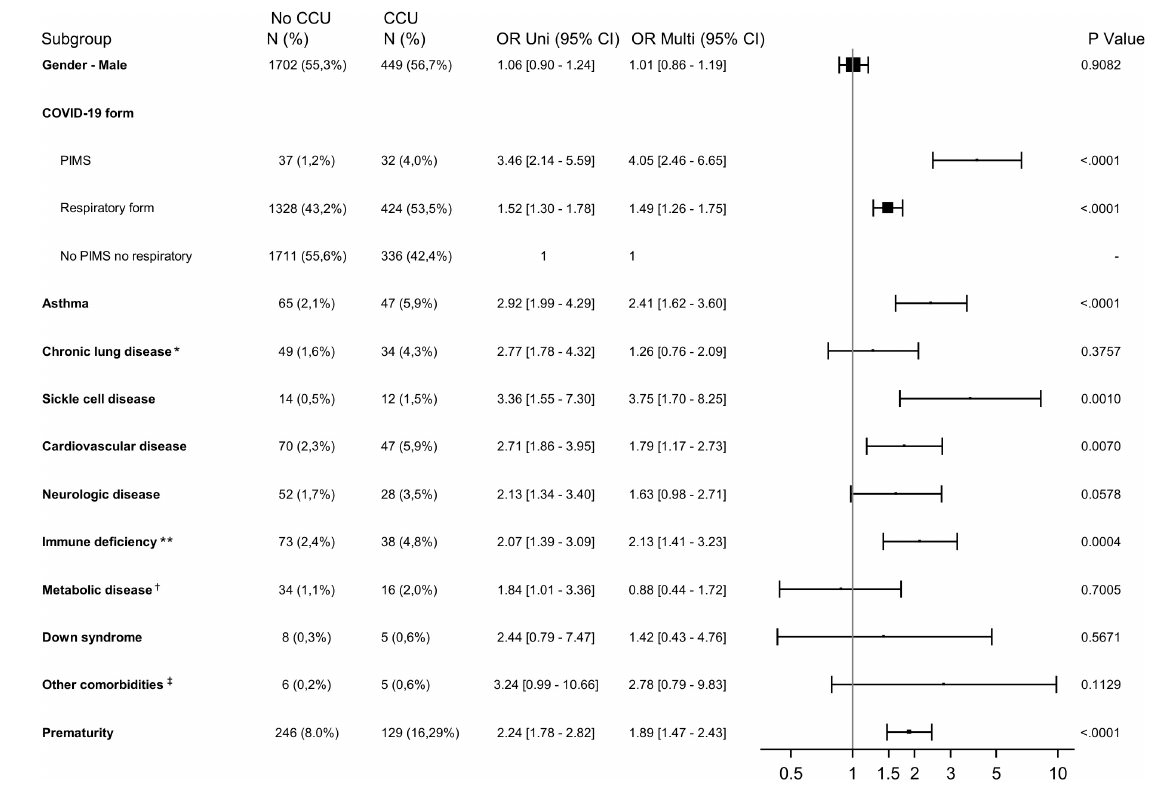
FIGURE4 Forest plot showing the odds ratio using univariable (Uni) and multivariable (Multi) logistic regression analysis for CCU admission for children younger than 2 years old. CCU, critical care unit; PIMS, pediatric multisystem inflammatory syndrome; OR, odds ratio; 95% CI, 95% confidence interval. *Excluding asthma; **including cancers; † excluding diabetes; ‡ renal disease, hepatic and gastric disease, and diabetes.